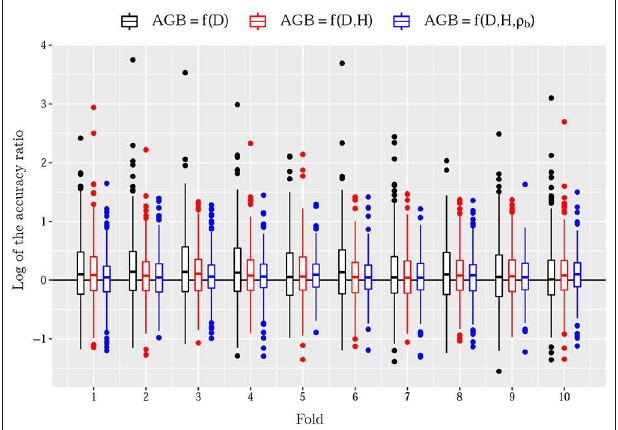
FIGURE 5 | Stratified 10-fold cross-validation results for three of the pan-tropical models. For each considered model, per validation fold, the distribution of the log of the accuracy ratio is shown (ln( ˆ AGB / AGB)). Each fold contains ∼ 400 observations. Distributions are represented via standard format box-and-whisker. It is observed that the variance of these distributions tends to reduce as additional predictor variables are added. The median value of these distributions is consistently greater than zero, signifying predictions of AGB are generally larger than observed AGB.